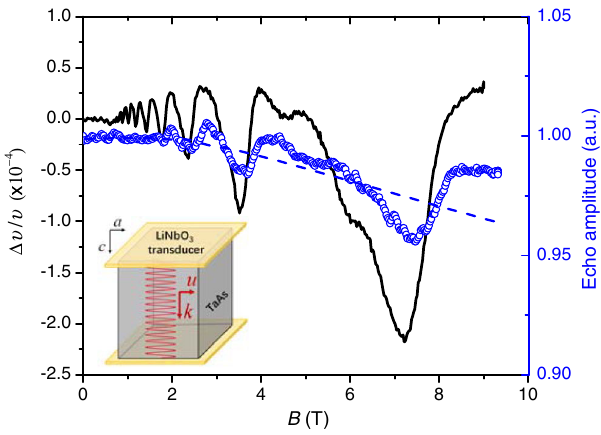
0 FIG. 5. Comparison of κ ð B Þ measured for sample TAc in parallel ( dT k c , B k c ) and perpendicular ( dT k c , B k a ) field configurations. The dashed black lines denote a smooth back- ð B Þ for κ ð B Þ and κ ð B Þ . It is clearly seen that κ ð B Þ ground κ k ⊥ bg bg for the parallel field configuration gradually increases, whereas that for the perpendicular field slightly decreases with B . These ð B Þ between the two field apparently different trends of κ bg configurations provide strong support for CZS being involved in the magnetothermal conductivity. Furthermore, a semiquanti- tative fitting based on the CZS scenario is also shown [solid green κ ð B Þ line], which agrees reasonably well with the experimental cal results. Inset: The trend of the background contribution for the two different field configurations is much better demonstrated at T ¼ 8 K, where the F ≈ 7 T oscillations have almost disap- peared; cf. Fig. 3(b). At a much higher temperature ð T ¼ 150 K Þ , the data for κ k ð B Þ and κ ⊥ ð B Þ fall on top of each